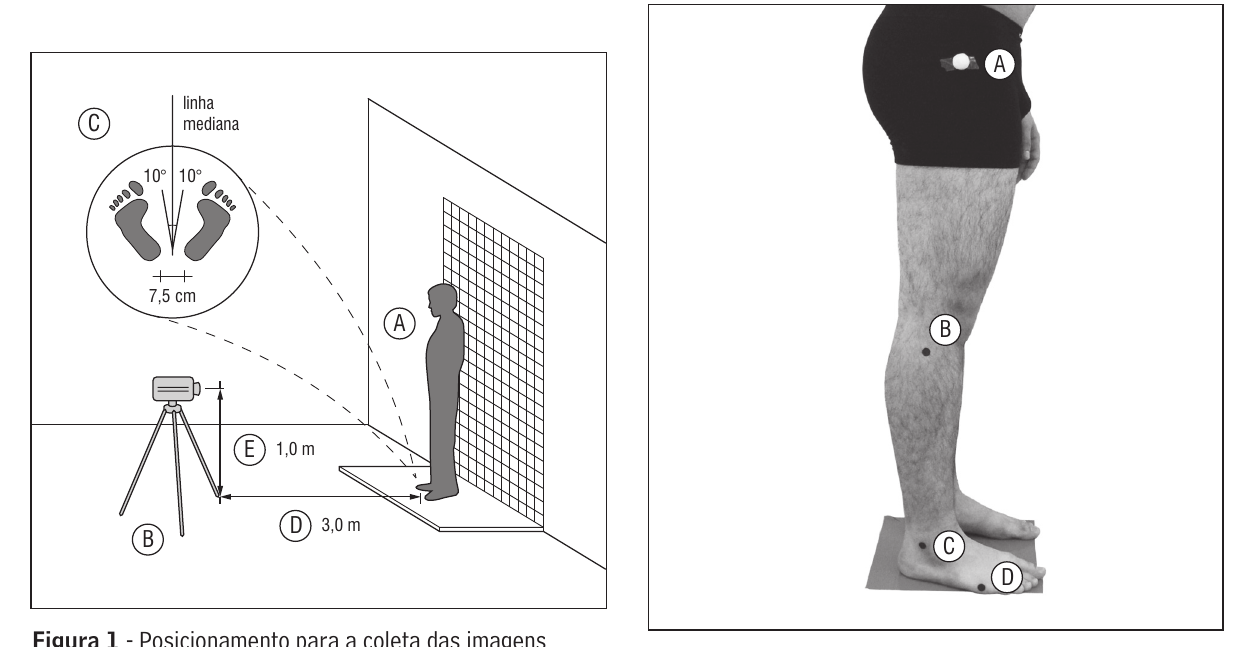
Figura 3 - Marcos anatômicos de referência para mensura- ção angular em vista lateral Legenda: Pontos: A = trocânter maior do fêmur; B = cabeça da fíbula; C = maléolo lateral do tornozelo; D = cabeça do quinto metatarsiano.